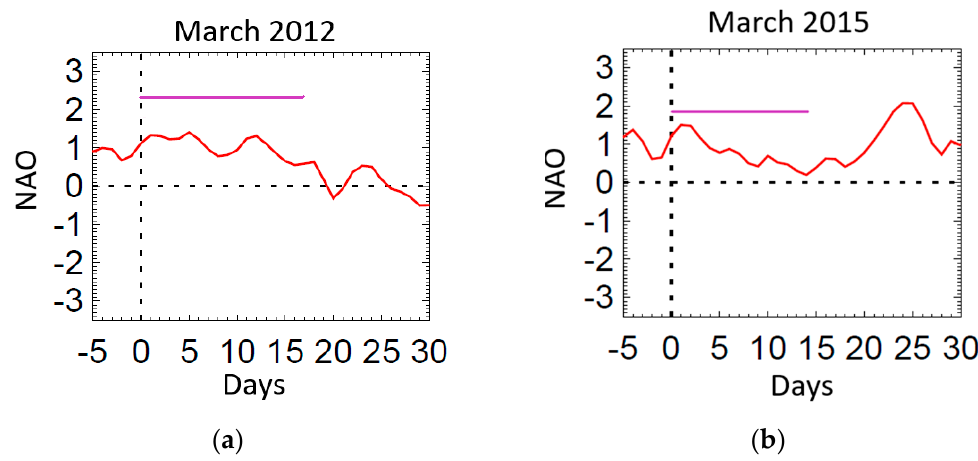
Figure 5. The NAO index for a time interval of 5 days before and 30 days after the beginning day of the abrupt temperature increase in Madison, Wisconsin in March 2012 ( a ) and March 2015 ( b ). The time interval of the integrated SEP events (horizontal purple line) coincides with a period of highly positive values of the NAO index.